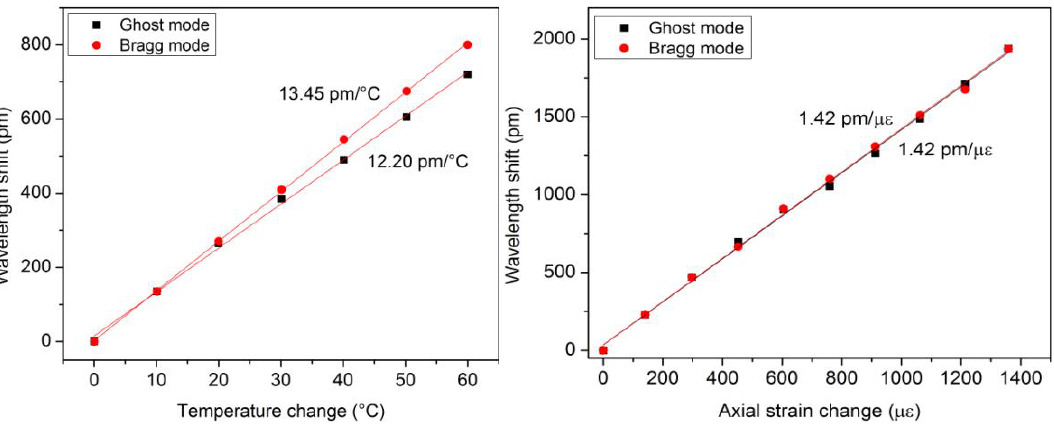
Figure 5. Wavelength shifts as a function of strain and temperature for the Bragg and ghost mode resonances.